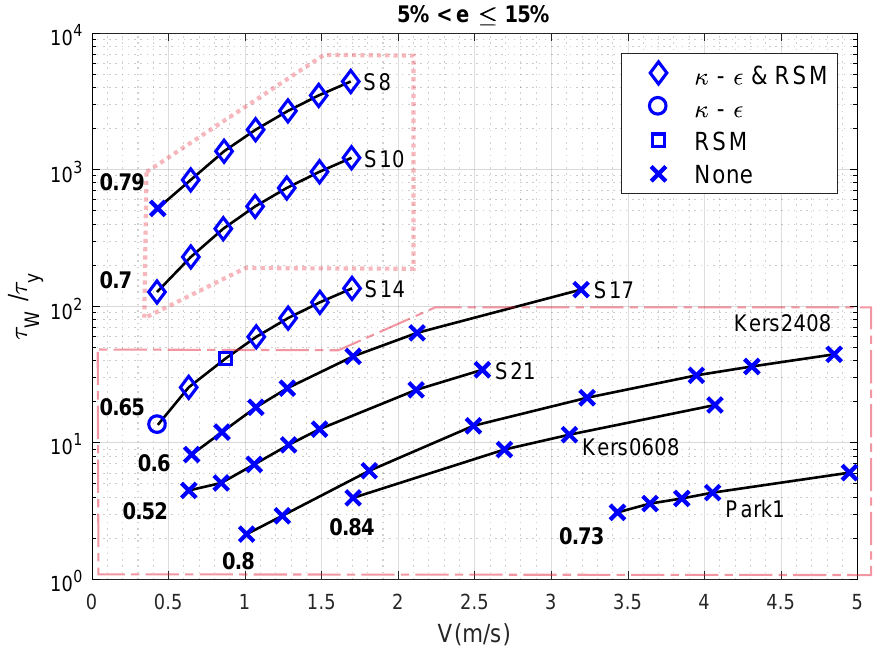
Figure 11. Performance of the standard RANS models to achieve an error 5% < e ≤